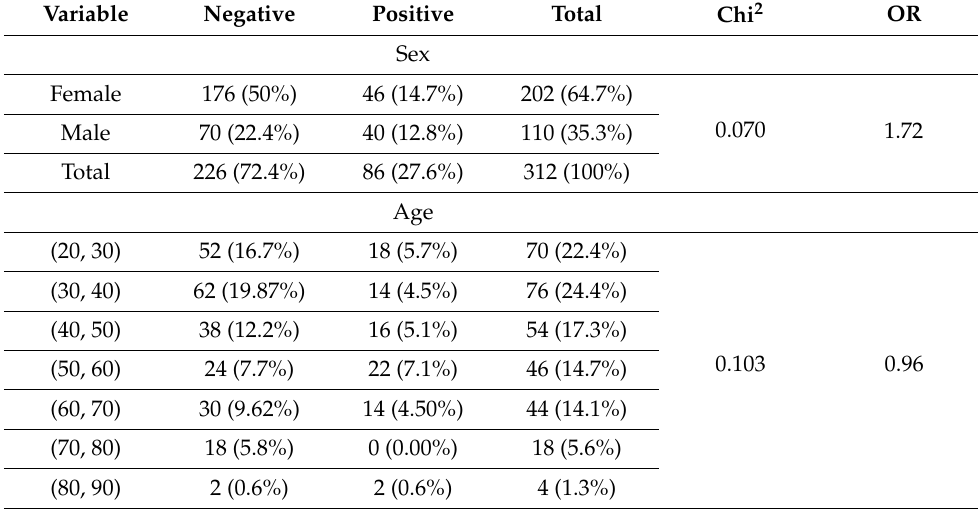
Table 6. Sociodemographic data.